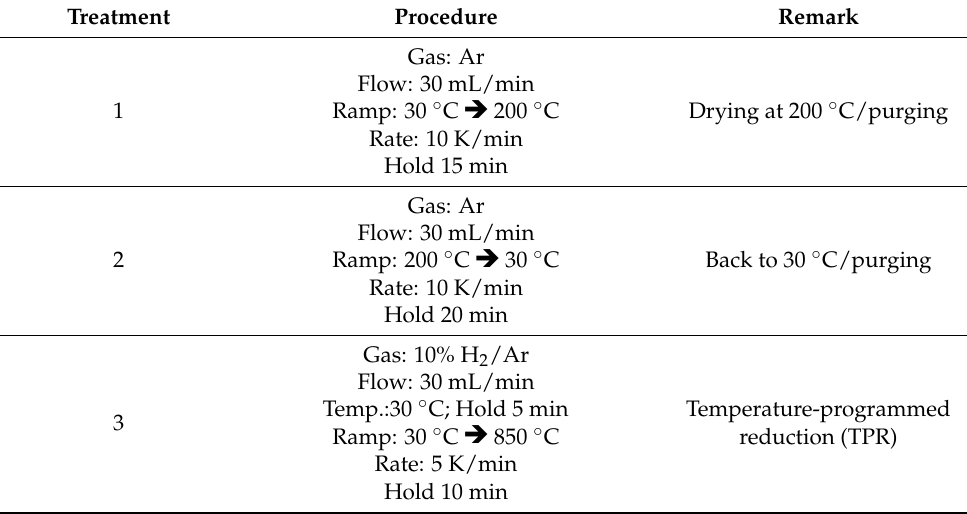
Table 8. Treatment procedures for the TPR measurements.